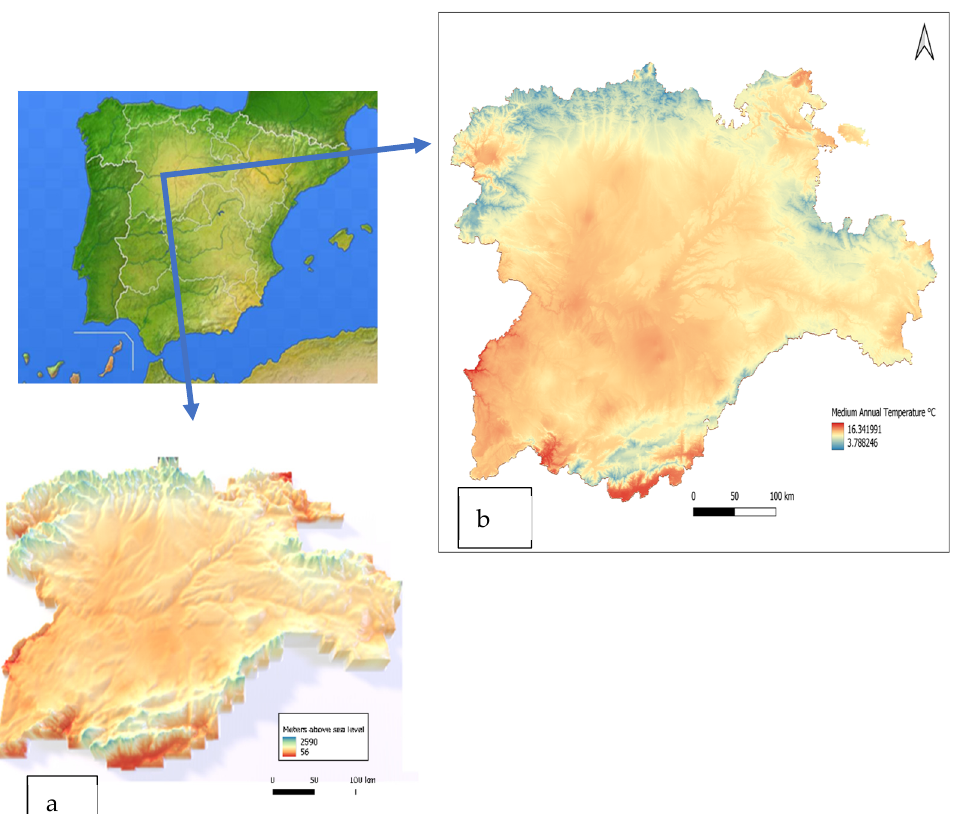
Figure 1. Map of the area of study (Castilla y León, NW Spain). ( a ) Altitude. ( b ) Medium annual temperature. Source: Atlas Agroclim á tico de Castilla y Le ó n—ITACYL-AEMET-2013